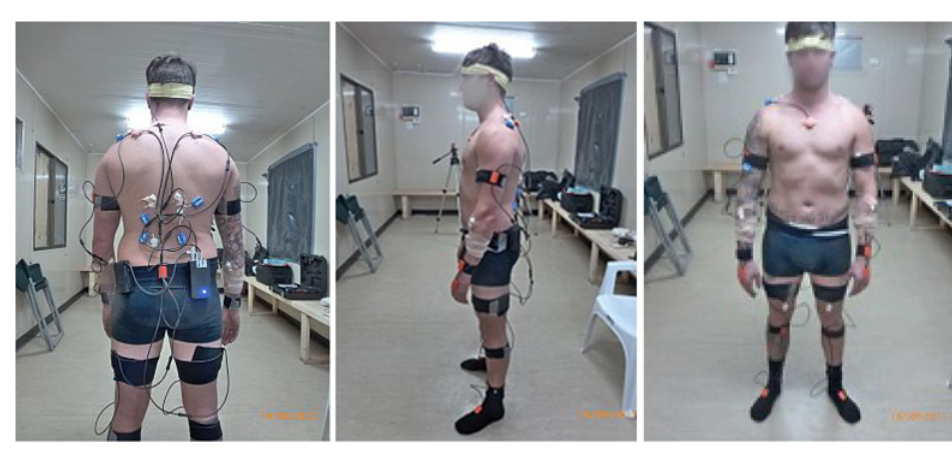
Figure 1 Positioning of the